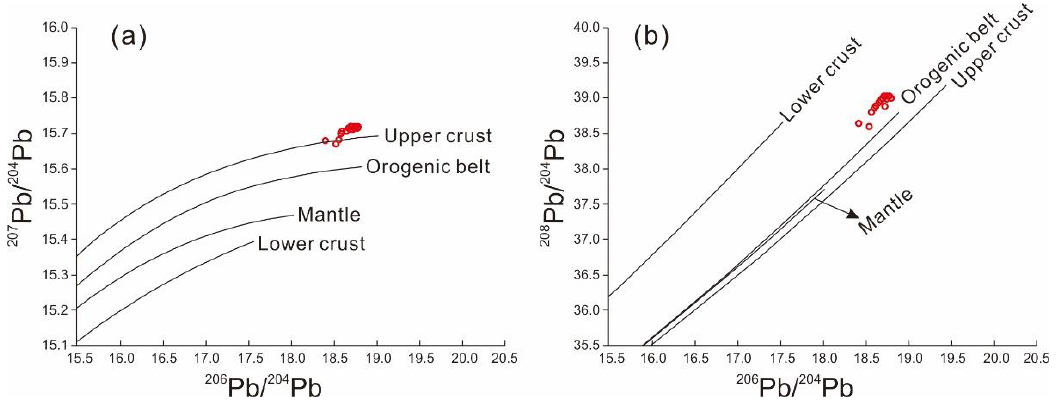
Figure 10. 207 Pb/ 204 Pb– 206 Pb/ 204 Pb uranogenic ( a ) and 208 Pb/ 204 Pb– 206 Pb/ 204 Pb thorogenic ( b ) for the Bawang deposit.